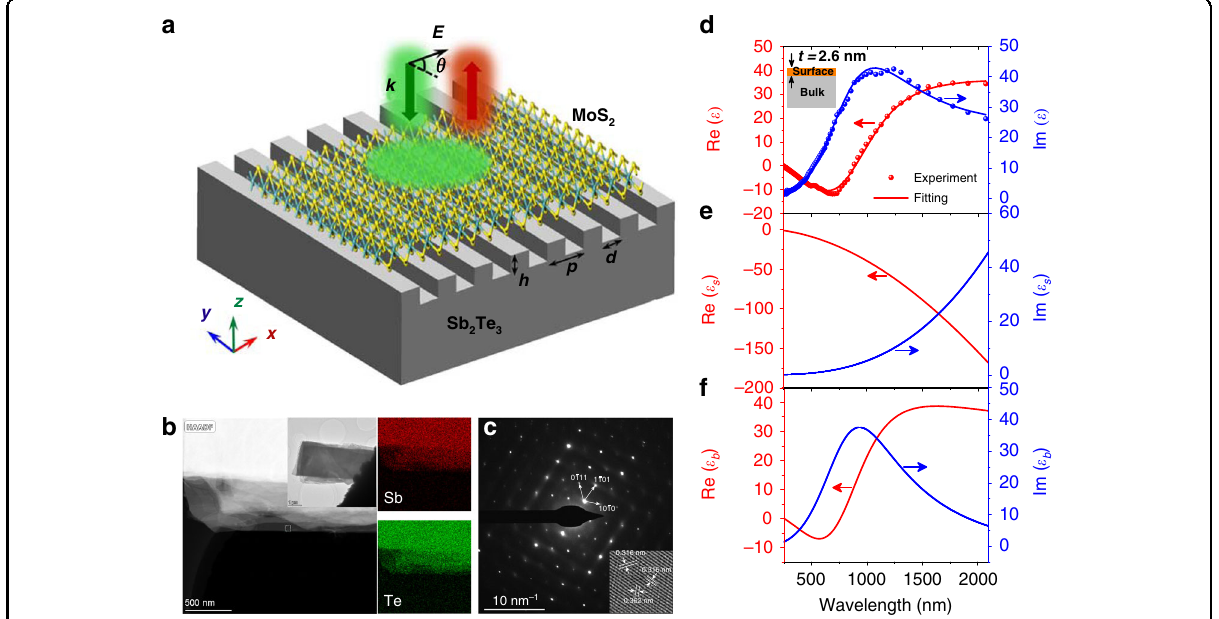
Fig. 1 TI nanostructure, material characterization, and optical constant. a Schematic of a Sb 2 Te 3 TI nanogroove grating with height h , width d , and pitch p underneath monolayer MoS 2 . The light is incident on the nanostructure with a polarization angle of θ . b TEM high-angle annular dark- fi eld (HAADF) image of a part of a thin Sb fl ake (inset) on the carbon support fi lm of a copper microgrid. The dotted rectangle denotes the 2 Te 3 micro area selected for electron diffraction and high-resolution TEM. The right images are the EDS mapping pictures of the measured part of the Sb 2 Te 3 micro fl ake for determining the spatial distributions of elements Sb and Te. c SAED pattern and HRTEM image (inset) of the Sb 2 Te 3 single crystal. d Measured (circles) and fi tted (curves) relative permittivities of the Sb 2 Te 3 single crystal in the UV, visible, and near-infrared ranges. The fi tted real and imaginary permittivities are obtained from the ellipsometer software with a layer-on-bulk model (inset) for the Sb 2 Te 3 TI. e , f Real and imaginary permittivities of the conducting surface and insulating